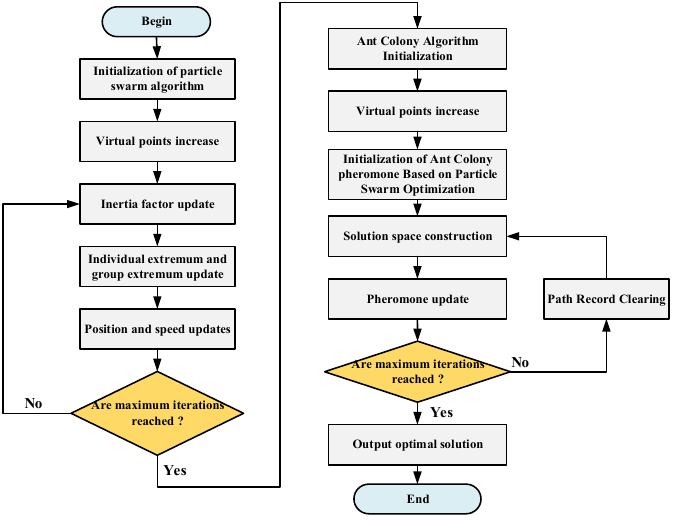
Figure 17. Flowchart of the hybrid algorithm.